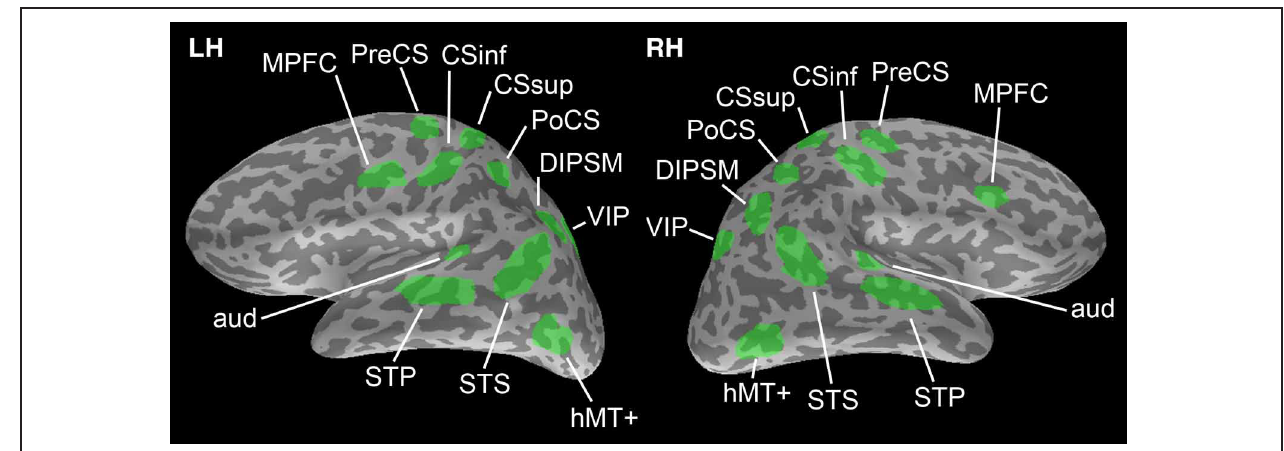
FIGURE 1 | Regions of interest chosen from which to generate simulation data. ROIs are adapted from Vaina et al. (2010); Calabro et al. (2011). There is no overlap between ROIs to avoid any issues in computing phase locking connectivity between